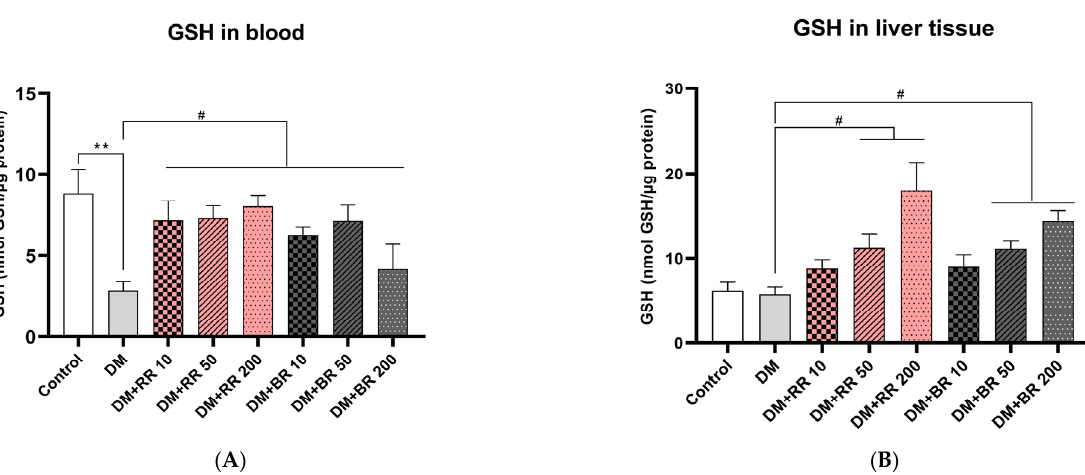
Figure 4. Effects of RR and BR on serum ( A ) and liver tissue ( B ) GSH levels. ** p < 0.01, diabetic control group vs. control group; # p < 0.05, treated group vs. diabetic control. Values represent mean ± S.E.M. (n = 8).